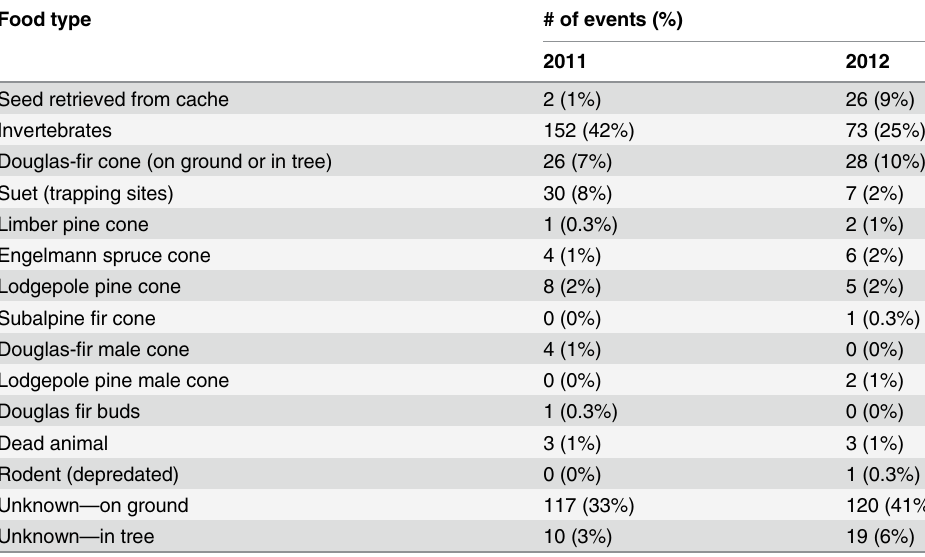
Table 5. Food consumed during foraging